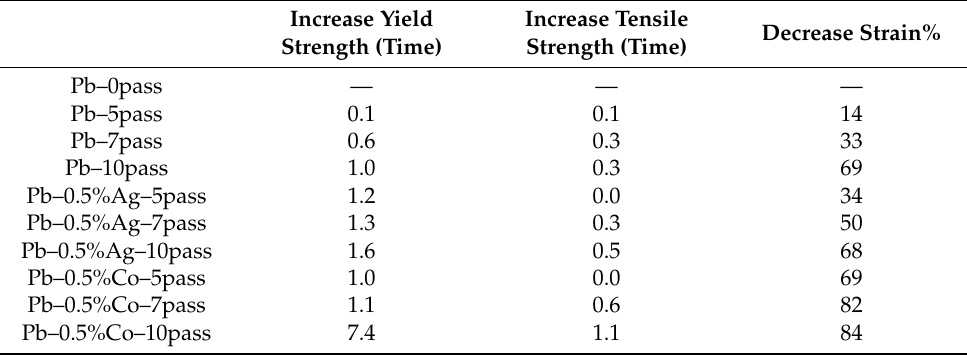
Table 3. Yield strength, tensile strength, and strain of various samples.